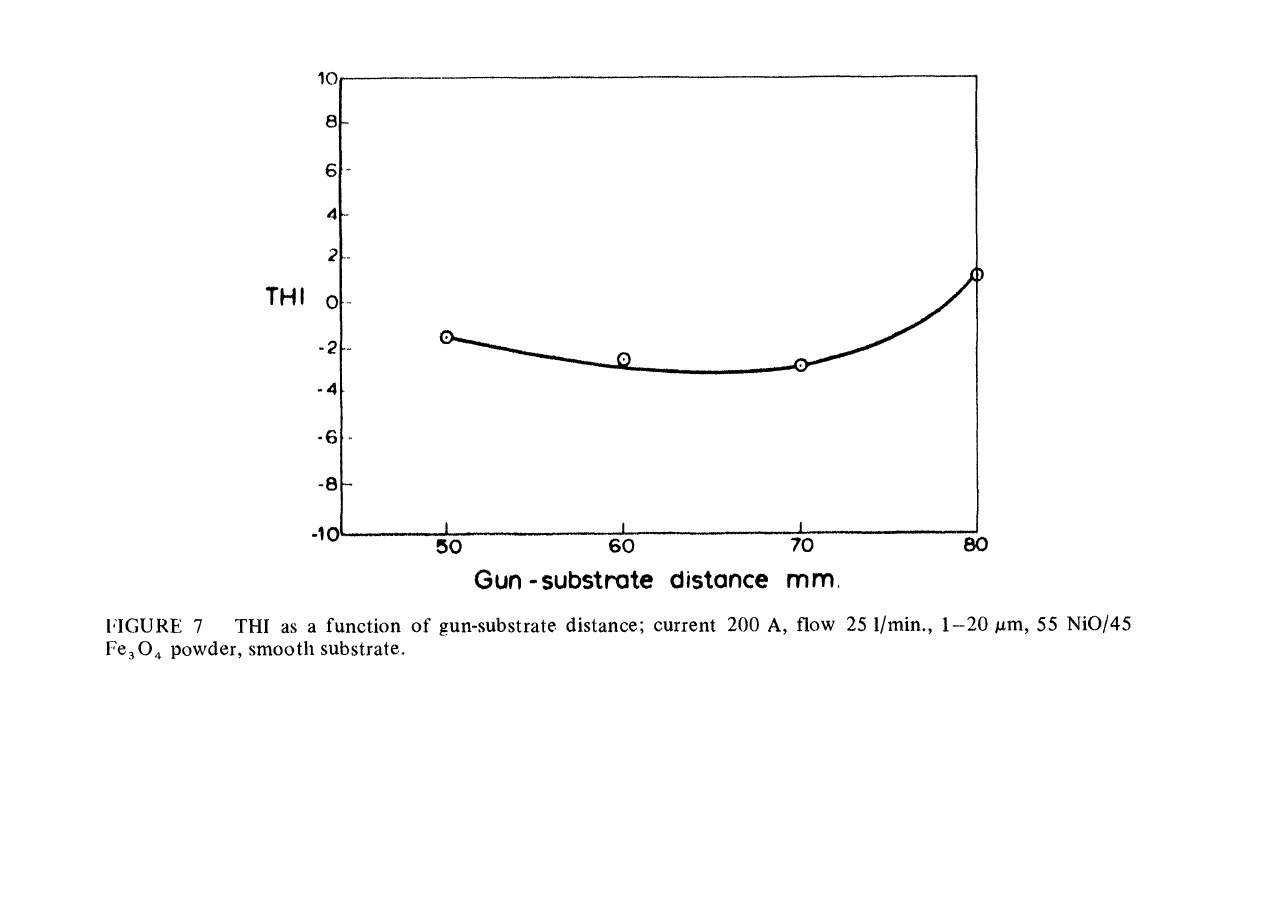
crossing the axis at higher values for higher NiO content.